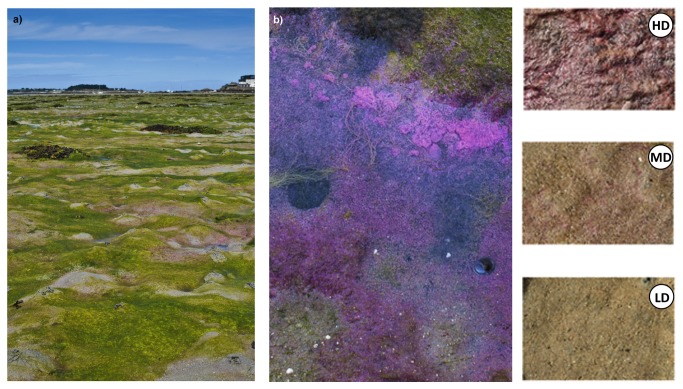
Picture of the Roscoff Aber bay affected by green macroalgae deposits (a) with details of a purple sulphur bacterial mat on top of magroalgal deposits (b), and details of three different types of mats selected for the study (HD: high density, MD: medium density, and LD: low density of purple sulphur bacteria).